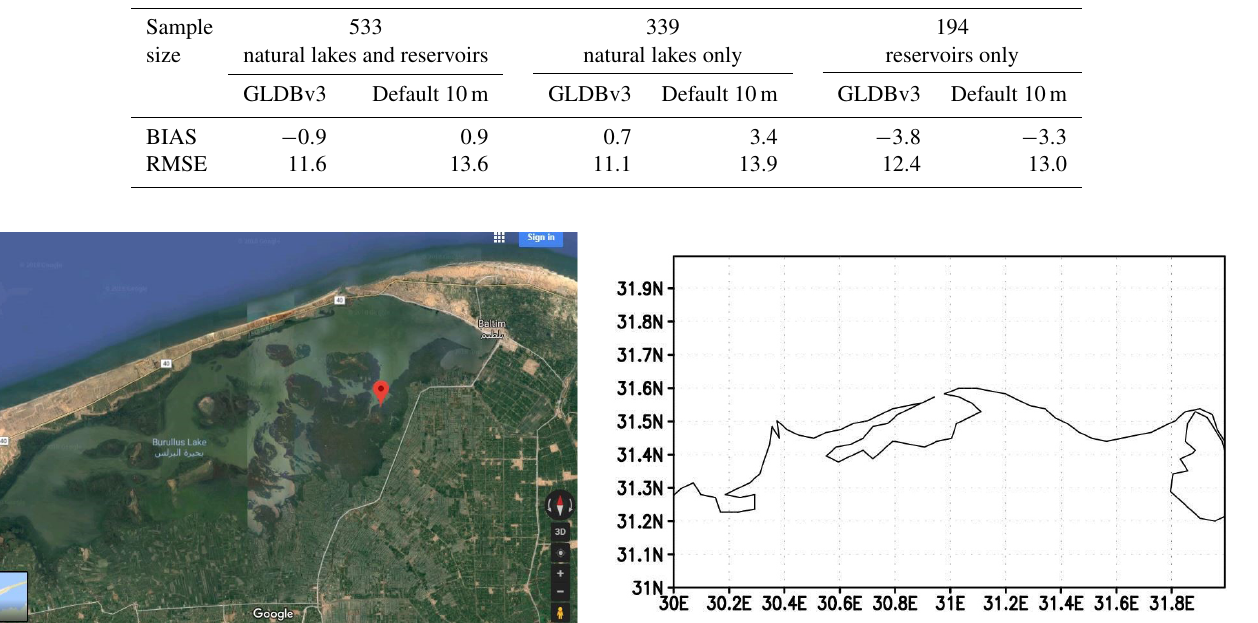
Figure 2. Burullus el Nahr Lagoon on Google Earth (to the left) (Google Earth, https://earth.google.com/web/, 2019) and on ECO- CLIMAP2 (to the right).